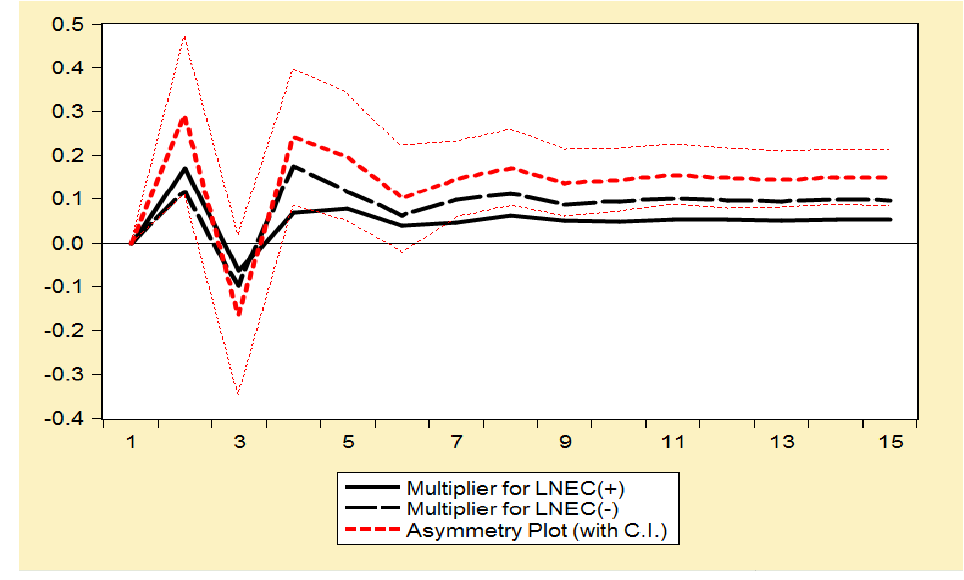
Energies 2022 , 15 , x FOR PEER REVIEW Figure 4. Dynamic Multiplier graph for LNEC. Figure 4. Dynamic Multiplier graph for LNEC.